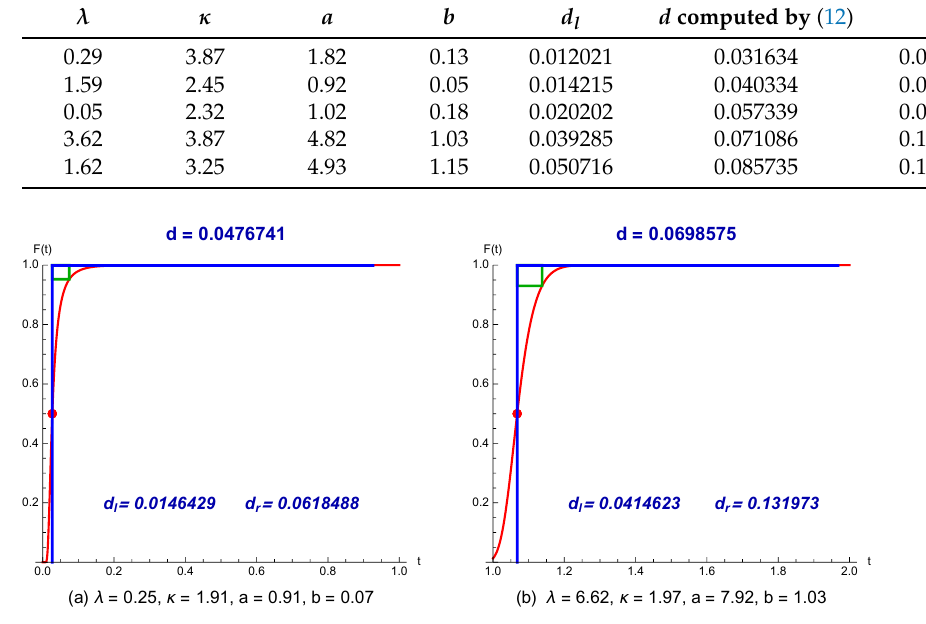
Figure 4. Approximation of CDF function of TCPOFW